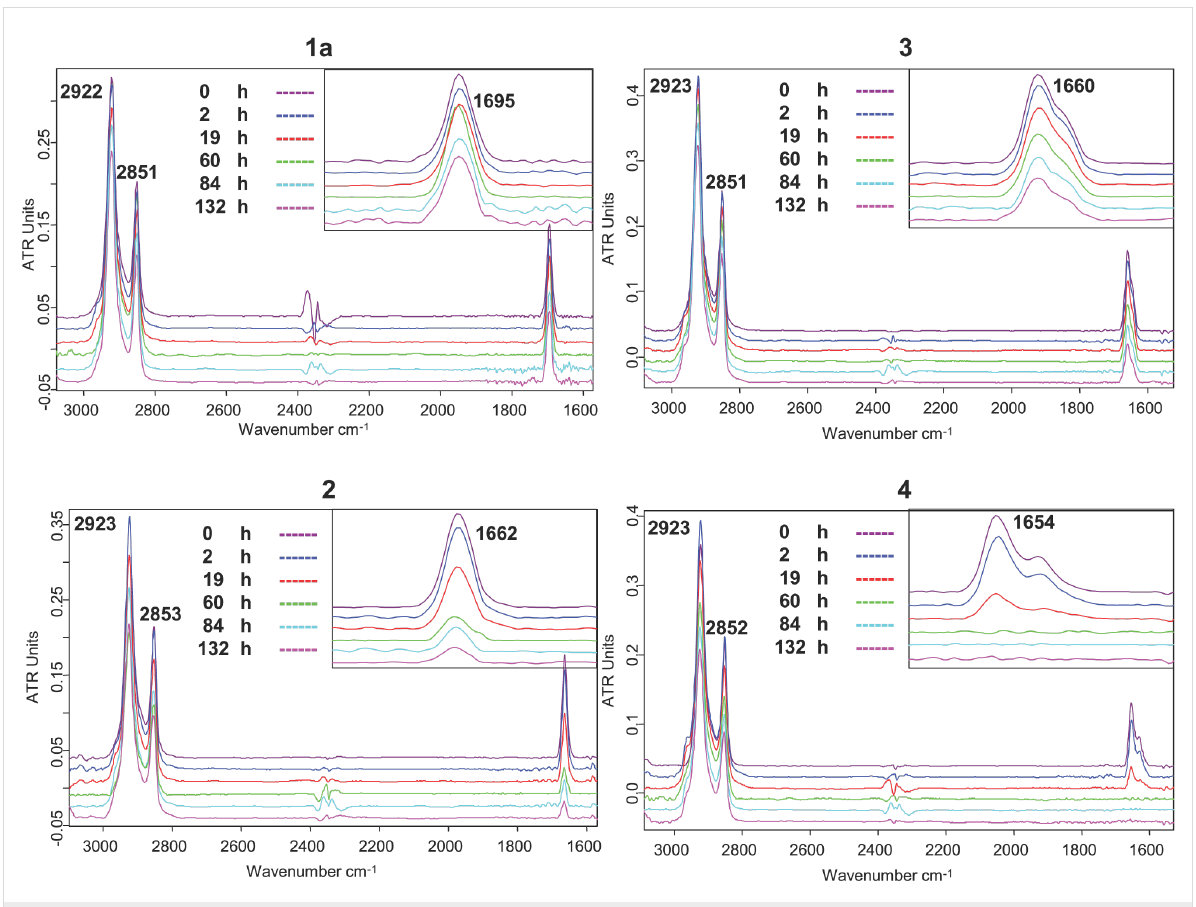
Figure 5: ATR–FTIR spectra of SAMs of compounds 1a , 2 , 3 and 4 , as deposited, and after oxidation with UV-A in air for 2 h, 19 h, 60 h, 84 h and 132 h.